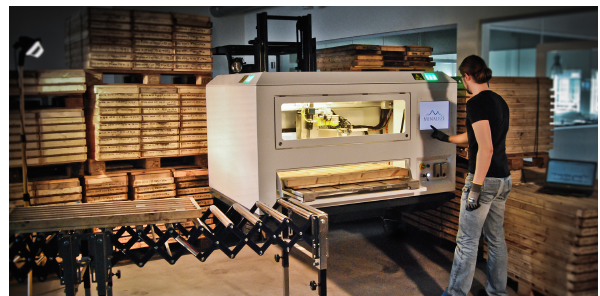
Figure 1. The new instrument described is a drill core scanner that intelligently handles entire drill core trays to produce chemical anal- yses of drill cores. Table 1. Technical specifications of the new instrument. Dimensions